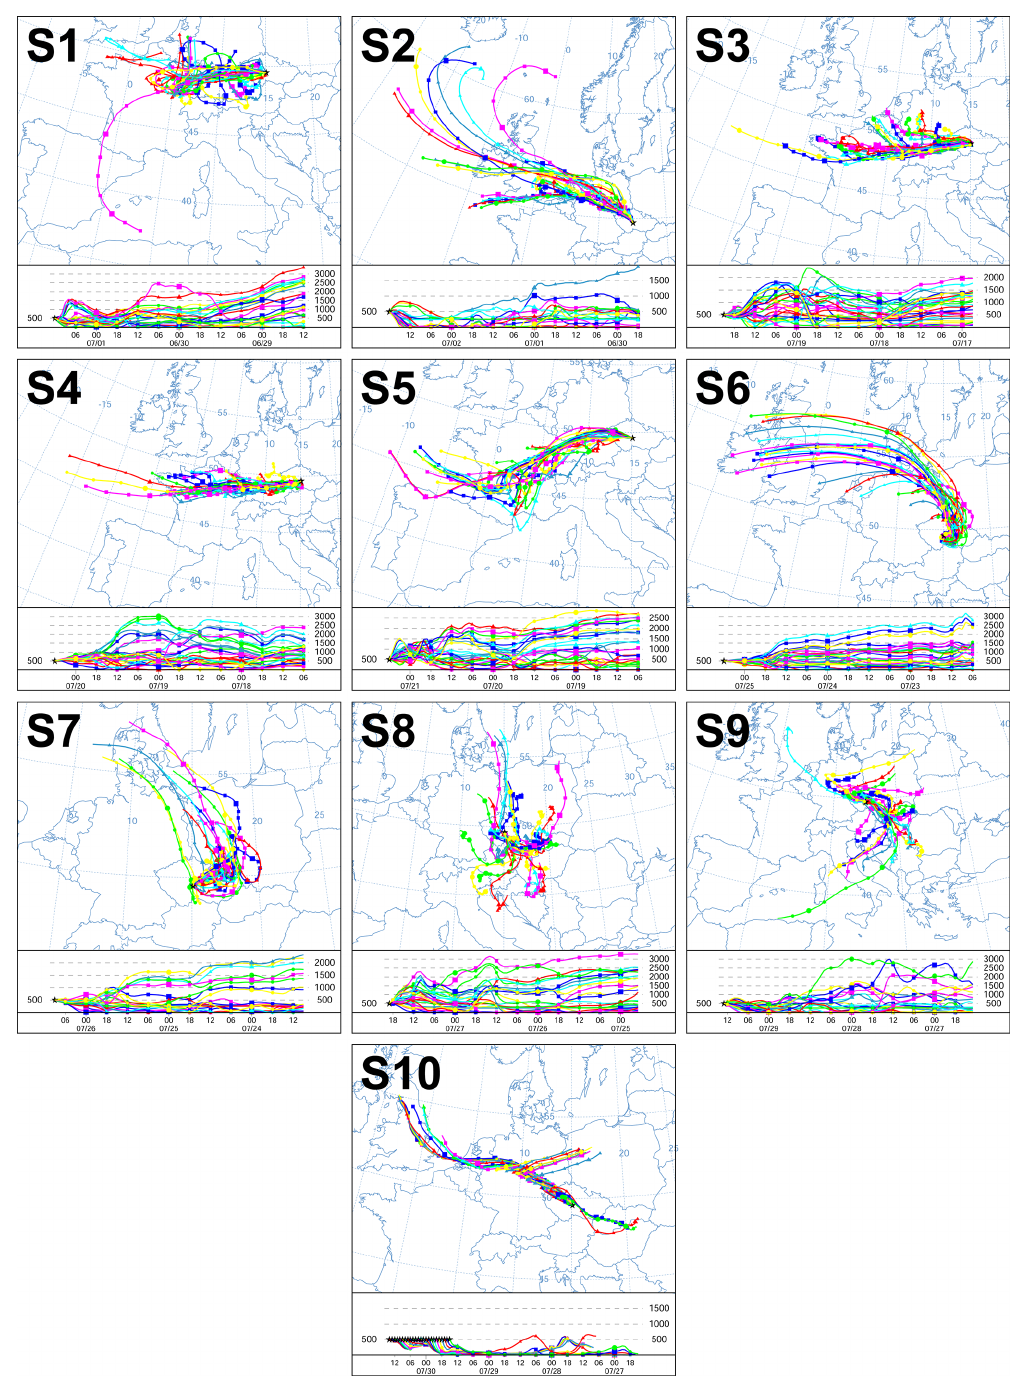
Figure A5. Backward air mass trajectories calculated by HYSPLIT for corresponding summer episodes (S1–S10) of high concentration of species size